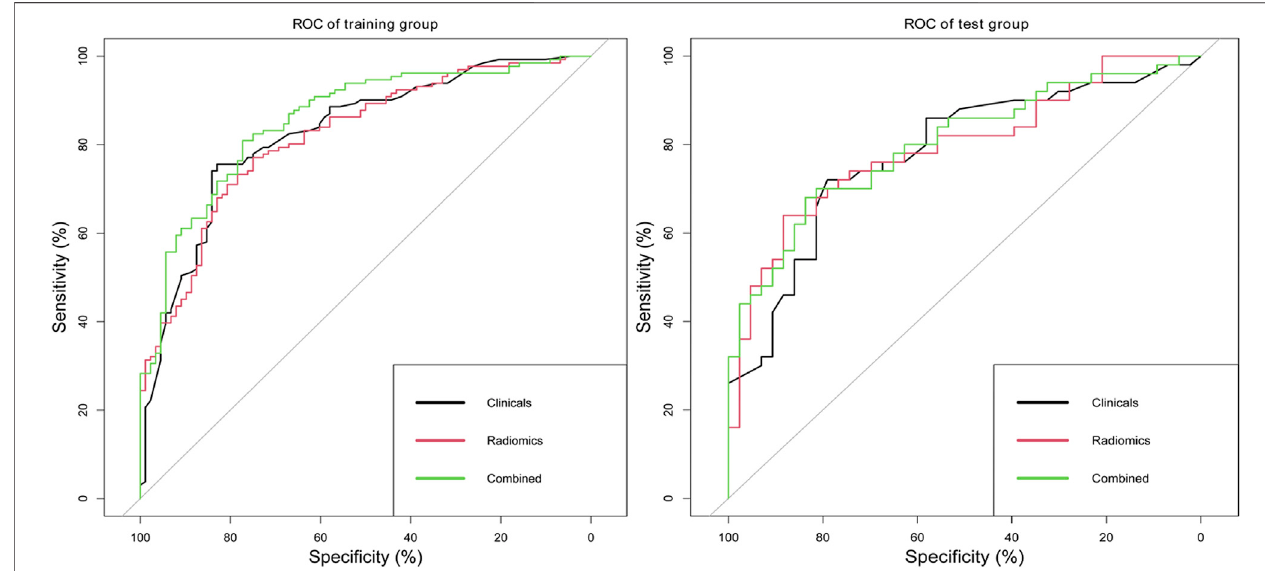
FIGURE 7 | ROC analysis of clinical model, radiomics model, and combined model in the training set and test set.